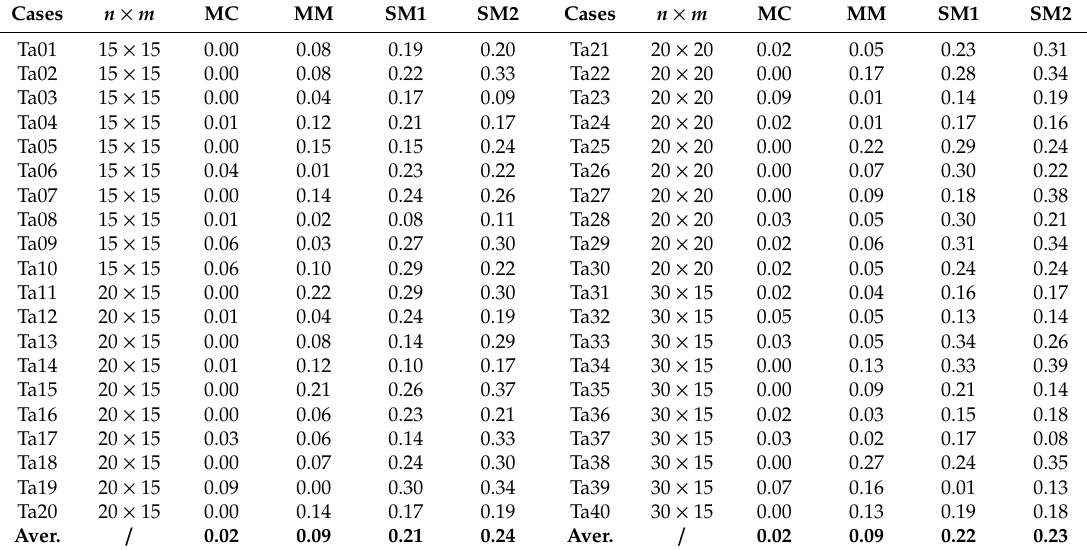
Table 4. The values of A d for the algorithms MC, MM, SM1 and SM2 in the problem set